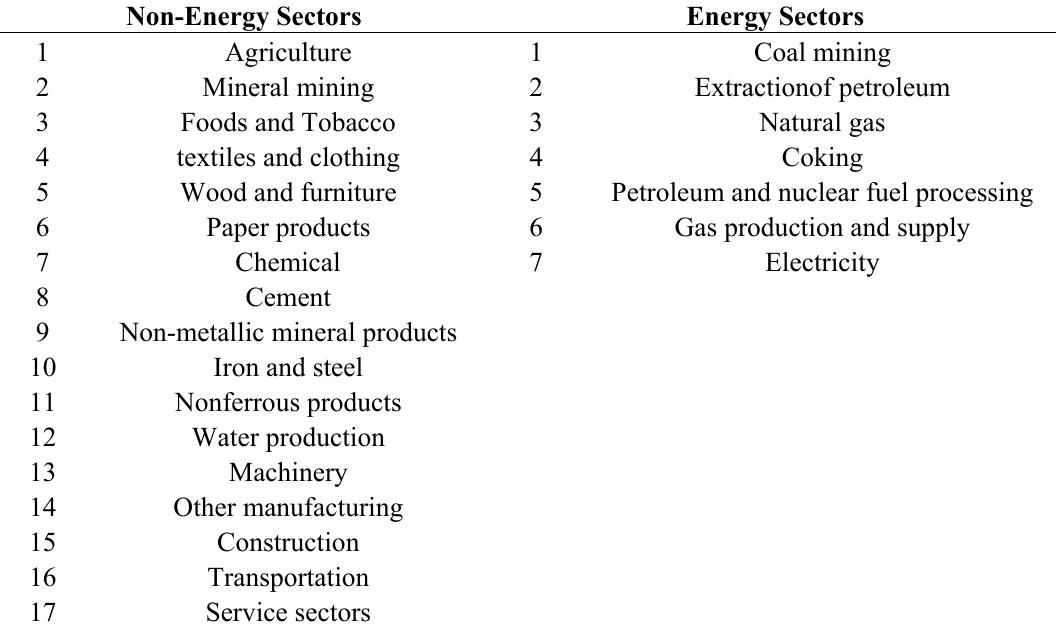
Table A1. The description of sector classifications used in this model.